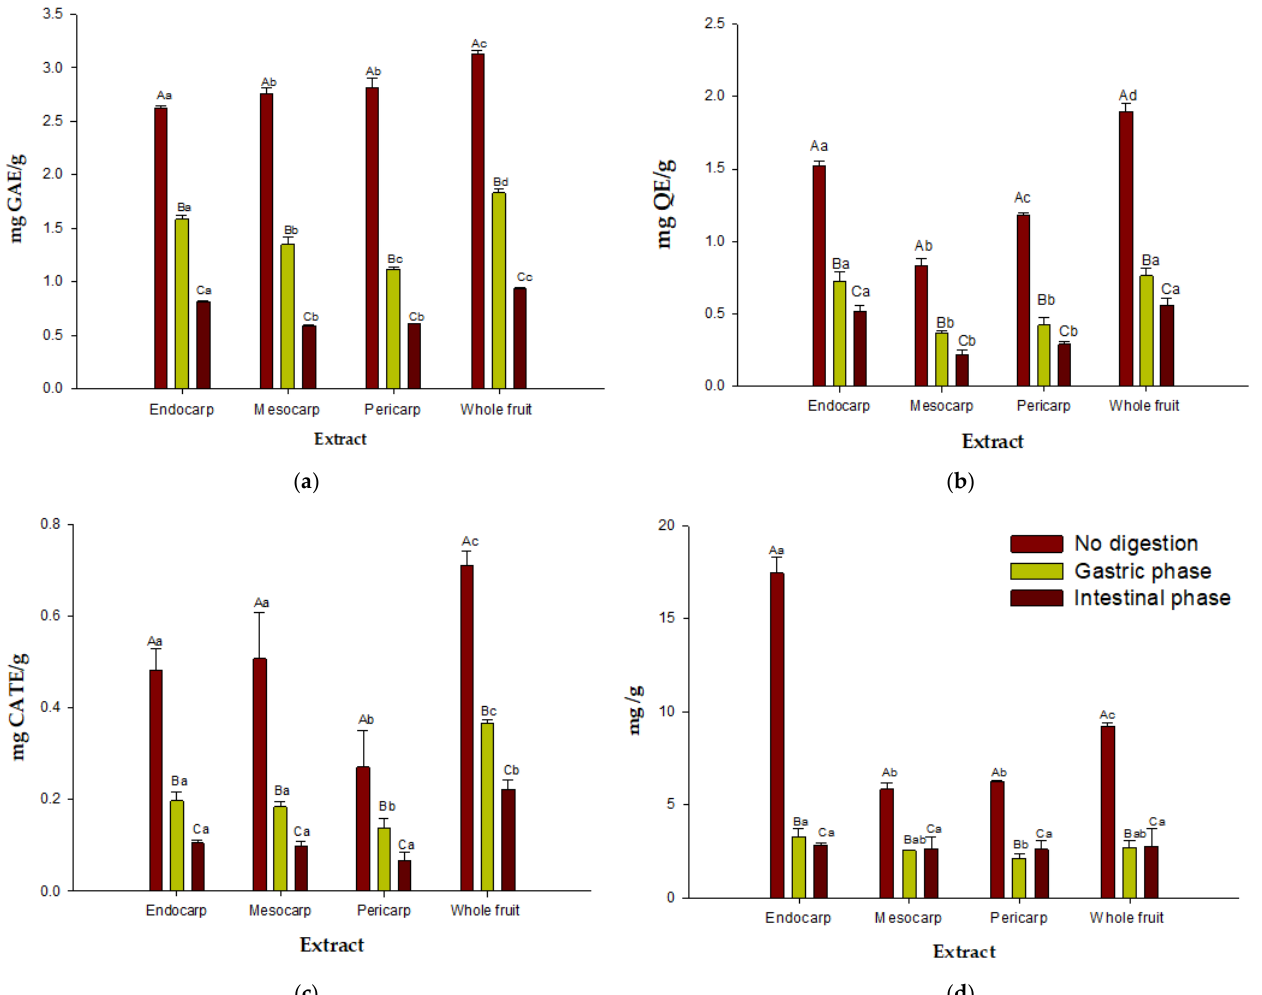
Figure 3. Total phenol content (mg GAE/g) ( a ), flavonoid content (mg QE/g) ( b ), tannin content (mg CATE/g) ( c ), and betalain content (mg/g) ( d ) before and after a simulated in vitro digestion. The capital letters A, B, C, D indicate significant differences ( p < 0.05) between the three treatments (undigested, gastric phase, intestinal phase) and the lower-case letters a, b, c, d represent significant differences ( p < 0.05) between the extracts (endocarp, mesocarp, pericarp, and whole fruit) during the same treatment, using the Tukey